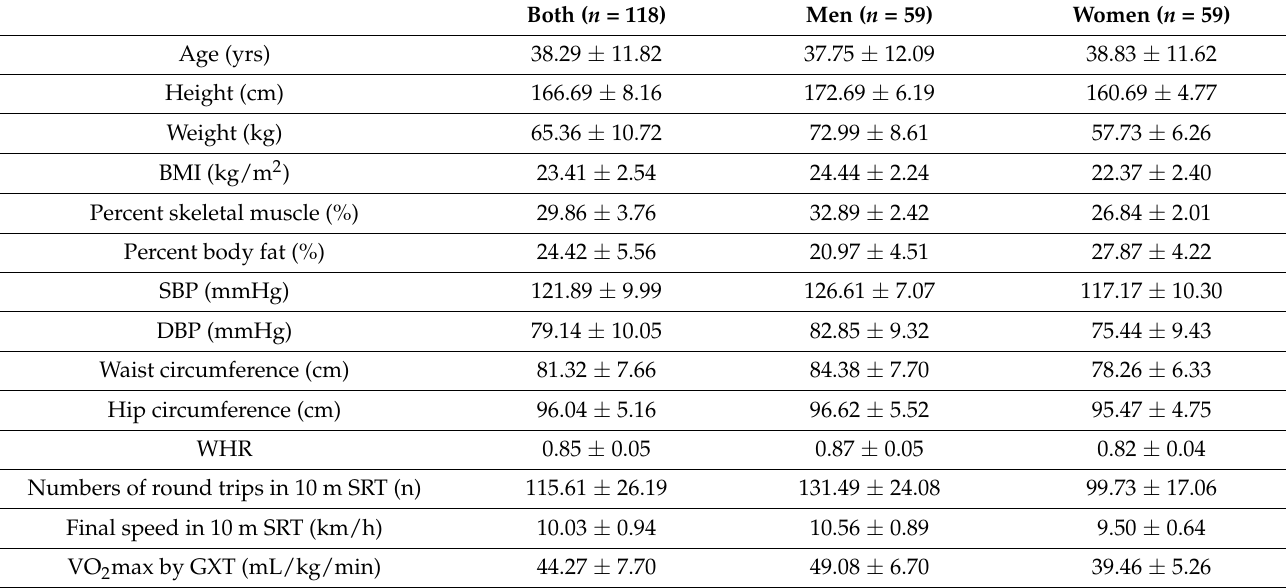
Table 1. Participants’